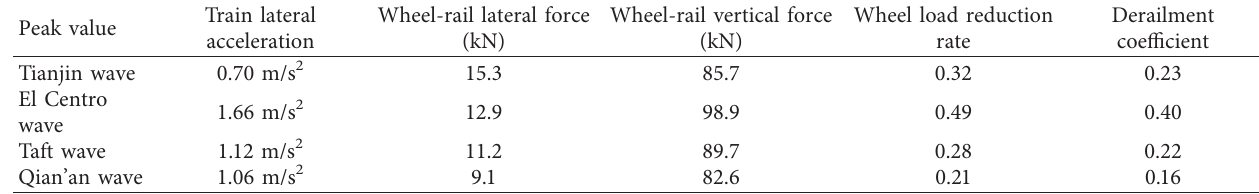
Figure 20: Wheel-track-subgrade time history under the Qian’an wave. (a) Lateral acceleration-time curve of the wheel. (b) Lateral force- time curve between the wheel and rail. (c) Vertical force-time curve between the wheel and rail. (d) Wheel load reduction rate-time curve. (e) Derailment coefficient-time curve. Table 7: Peak values of the dynamic response indexes of the wheel-rail